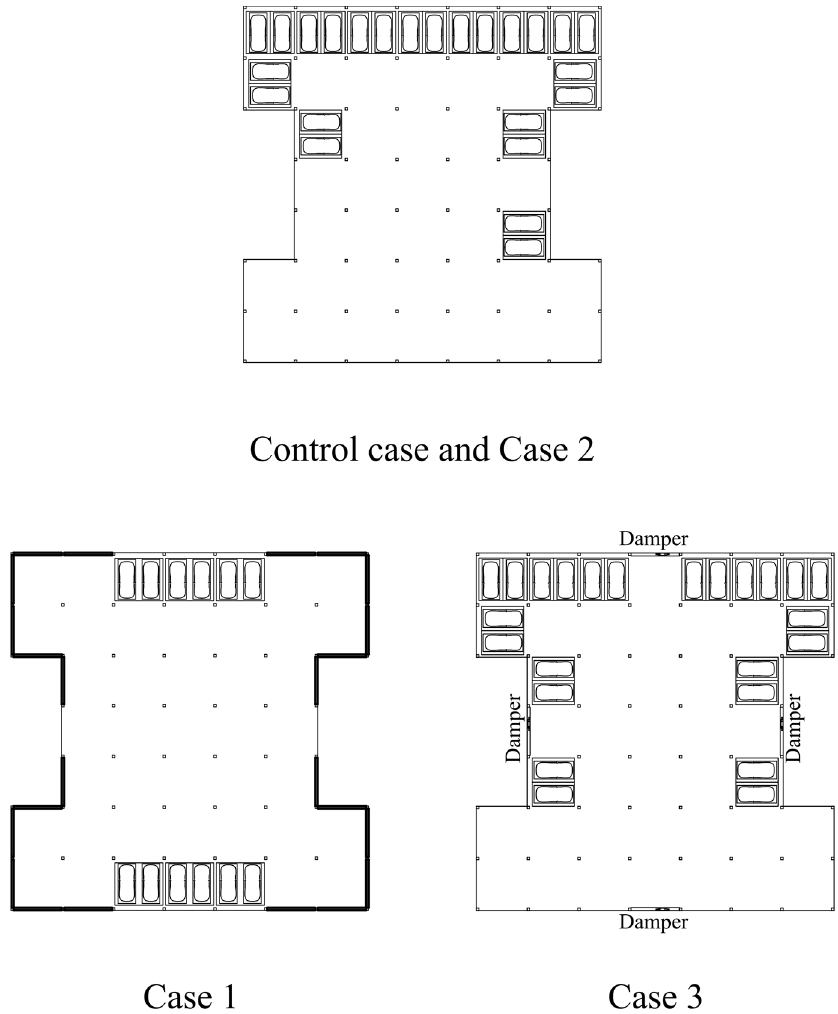
Figure 4. Arrangement of the parking spots in each of the cases.